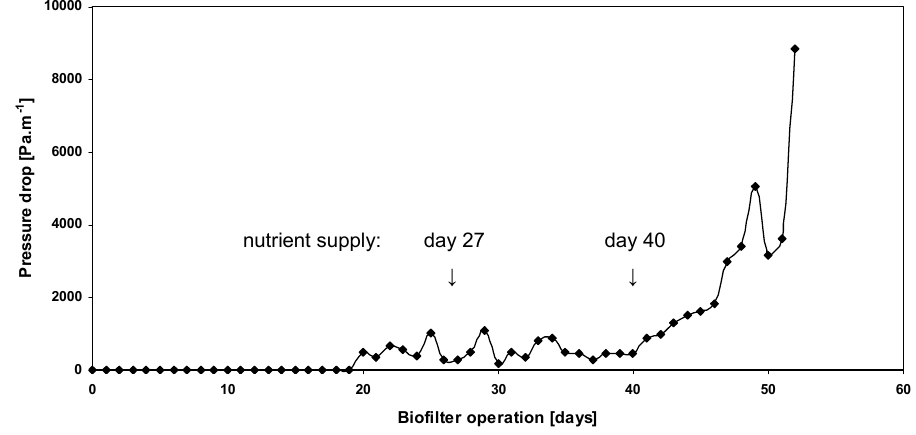
Figure 4. Profile of pressure drop across the bed height during BTF operation.